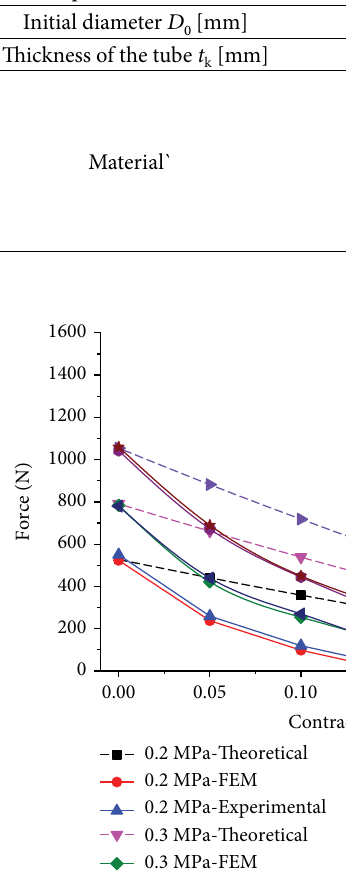
Figure 4: Static force-contraction relationship of a typical PAM at varying pressures obtained with the geometrical model, the FEM model and the experiment (isobaric